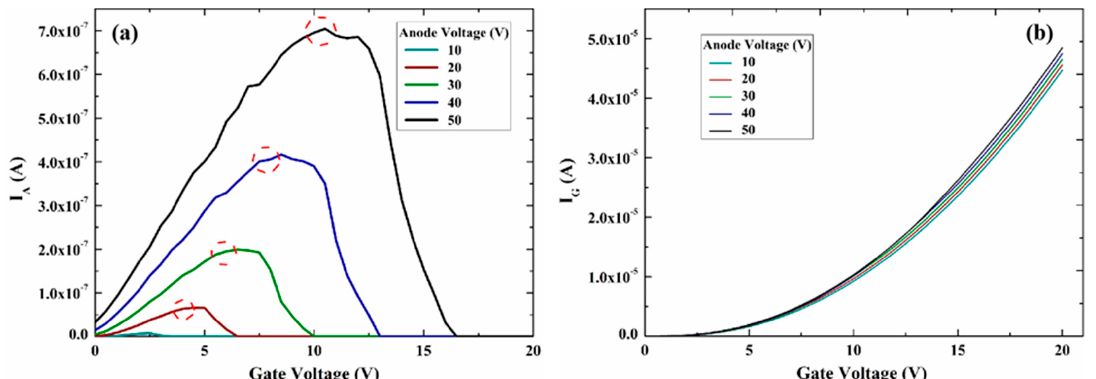
Figure 2 . Simulation of the electric performance of the NVC-based electron source, ( a ) the anode current versus the gate voltage and ( b ) the gate current versus the gate voltage.